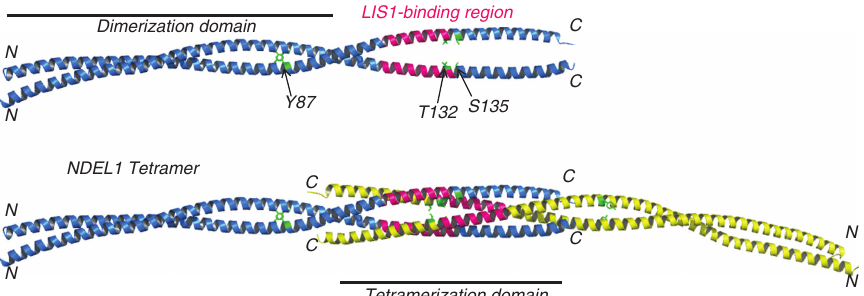
Figure 3 Coiled-coil crystal structure of NDEL1 with known post-translational modifications mapped. Only three known PTMs map onto the crystal structure of the NDEL1 coiled-coil domain fragment (residues 8–167; PDB ID: 2V71); these side- chains are shown in green and labeled on cartoon representations of the NDEL1 crystal structure, parallel dimer (top panel) and anti-parallel tetramer (bottom panel) (81); N- and C-termini for each chain and regions that facilitate dimerization and tetramerization are indicated. The essential LIS1-binding region on NDEL1 114–133 (96) is also shown (pink). Phosphorylation of NDE1 at T131 (directly equivalent to T132 of NDEL1) reduces its ability to interact with LIS1 (86). It can therefore be hypothesized that phosphorylation of T132 and/or S135 of NDEL1 may have similar effects on LIS1-binding. The Y87 site is highly solvent-exposed on the dimerization domain of coiled-coil structure and is thus readily accessible to